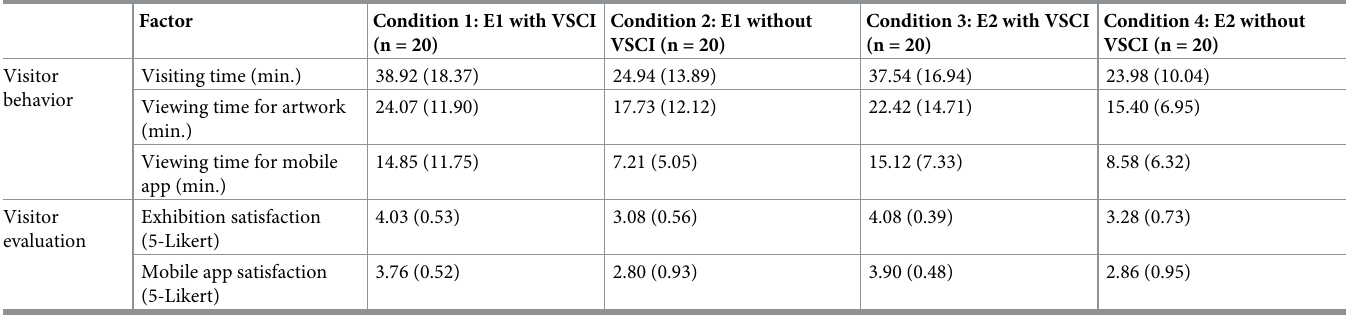
Table 3. Mean (and standard deviations) in exhibition appreciation divided by conditions.